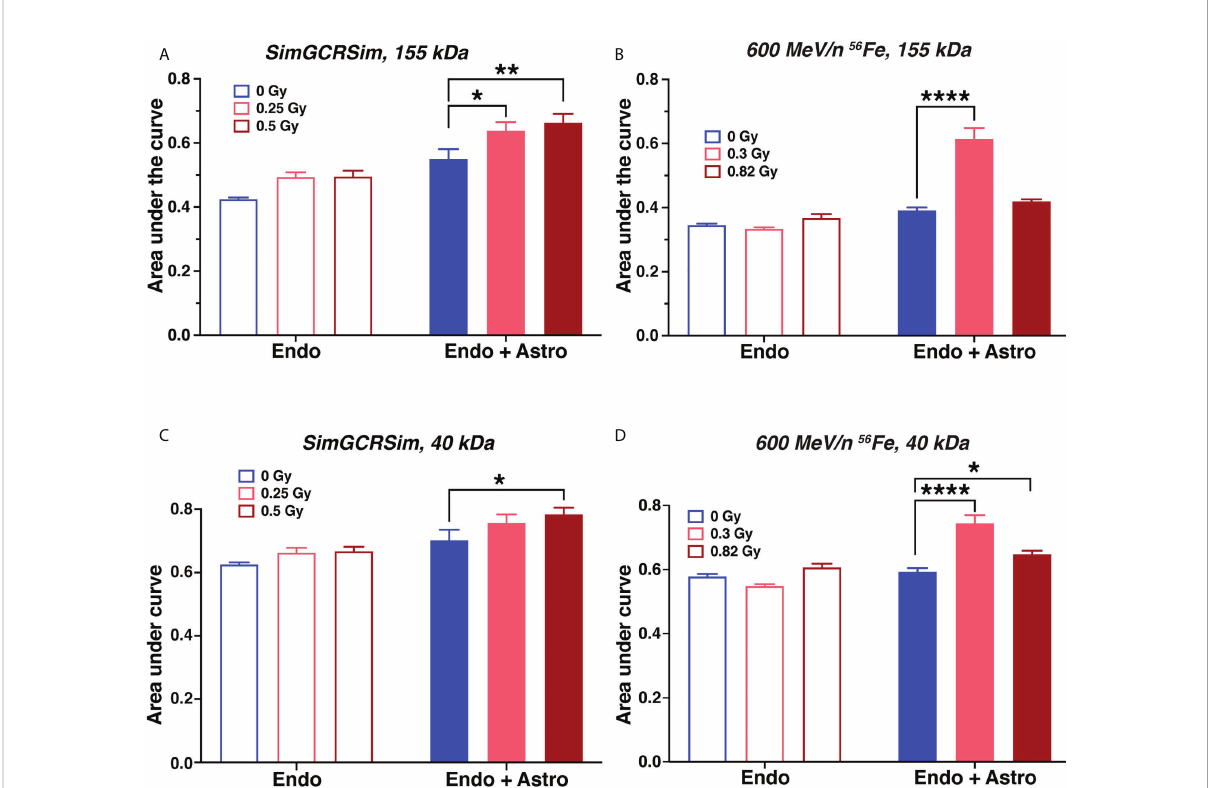
FIGURE 3 Astrocytes exacerbate acute endothelial cell barrier permeability caused by simulated deep space radiation. (A – D) . Vascular endothelial cell structure permeability 1 day after irradiation with 5-ion SimGCRSim (A, C) or 600 MeV/n 56 Fe particles (B, D) , quanti fi ed as area under the curve of relative fl uorescence of dye. Dye, TRITC-conjugated 155 kDa dextran (A, B) or FITC-conjugated 40 kDa dextran (C, D) . Endo, endothelial cells alone. Endo + astro, endothelial cells and astrocytes. Open bars, chips with endothelial cells only. Shaded bars, chips with endothelial cells and astrocytes. Blue, 0 Gy sham irradiation. Light red, lower dose (0.25 Gy SimGCRSim, 0.3 Gy 600 MeV/n 56 Fe). Dark red, higher dose (0.5 Gy SimGCRSim, 0.82 Gy 600 MeV/n 56 Fe). N = 8 chips per condition. Error bars, mean ± SEM. *p < 0.05, **p < 0.01, ****p < 0.0001, Dunnett ’ s multiple comparison test, 2-way ANOVA. Non statistically signi fi cant changes are not